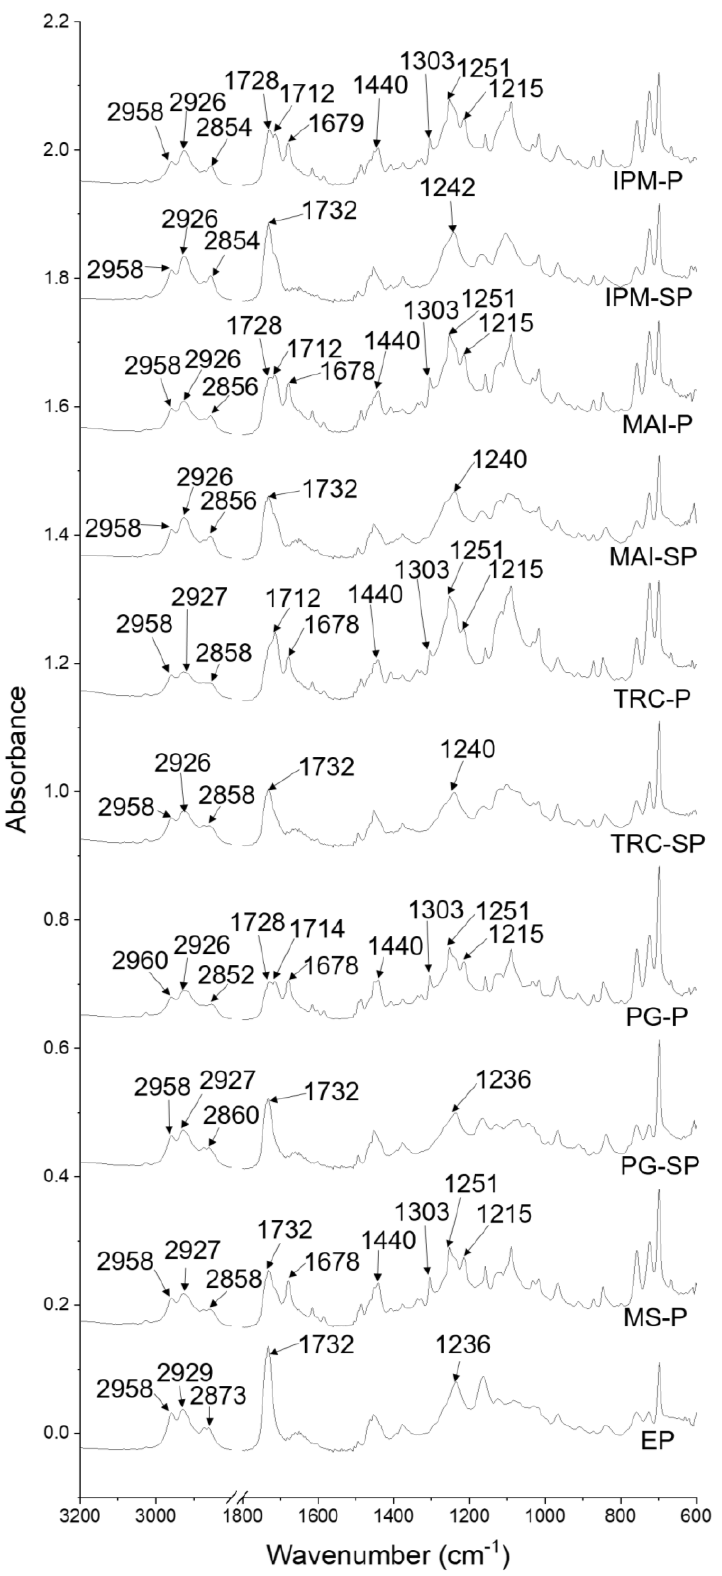
Figure 3. ATR − FTIR spectra of patches formed including EP (without solvent and drug), MS-P (with drug but without solvent), -SP (with solvent only) and -P (with drug and solvent). PG: propylene glycol; TRC: Transcutol ® P; MAI: Maisine ® CC; IPM: isopropyl myristate.